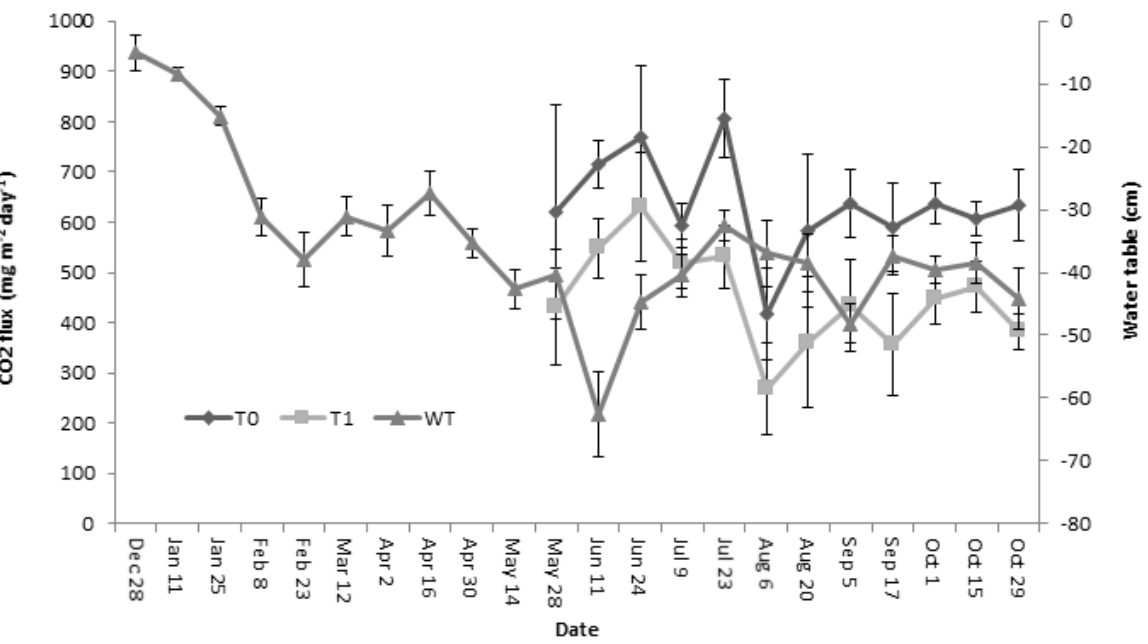
Figure 3. Water table (WT) fluctuation from December 2016 to October 2017, and carbon dioxide (CO 2 ) fluxes from May to October 2017 for the shallow (T0) and the deep (T1)